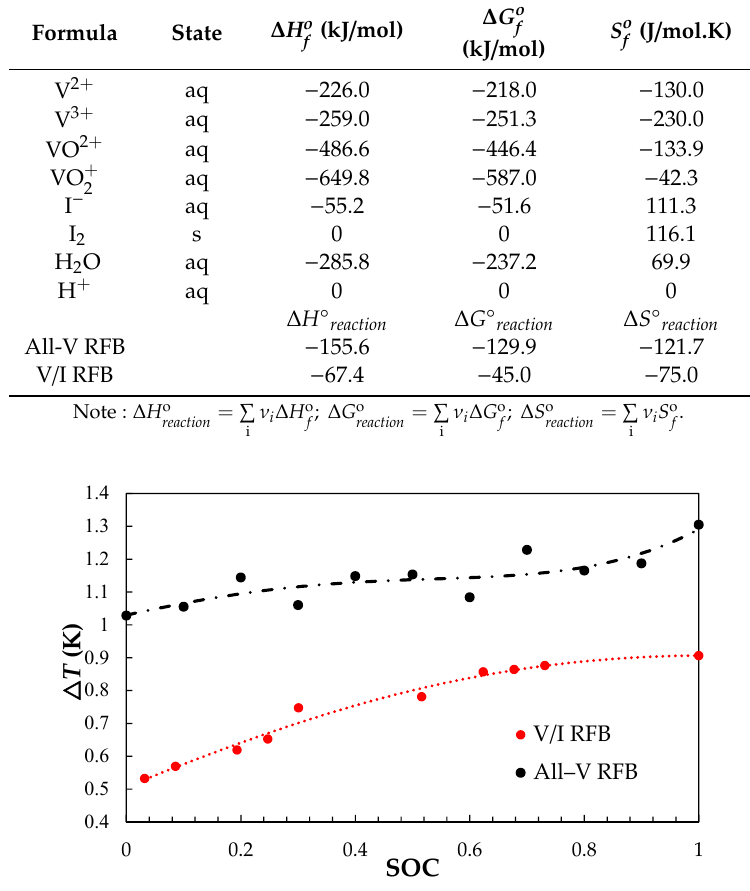
Figure 3. The temperature change ( Δ T ) of charge-discharge by monitoring of an infrared thermal imaging (ITI) of all-V RFB and V / I RFB as a function of the state of charge (SOC).